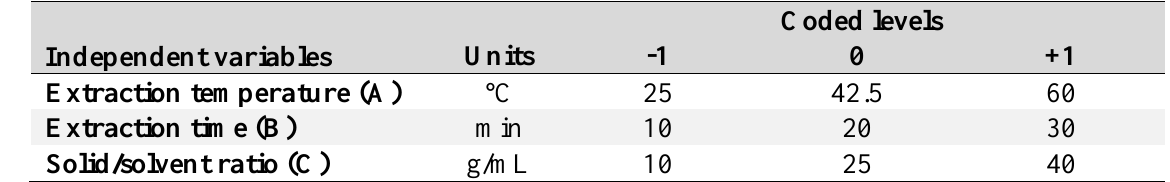
Table 1. Independent variables and their coded and actual